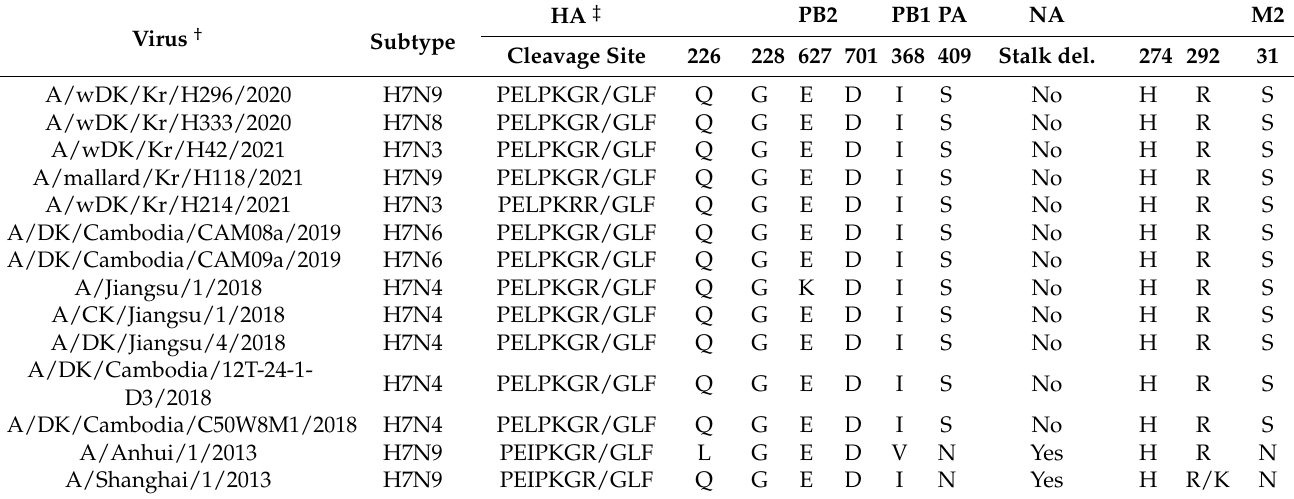
Table 3. Molecular characteristics associated with viral pathogenicity of H7